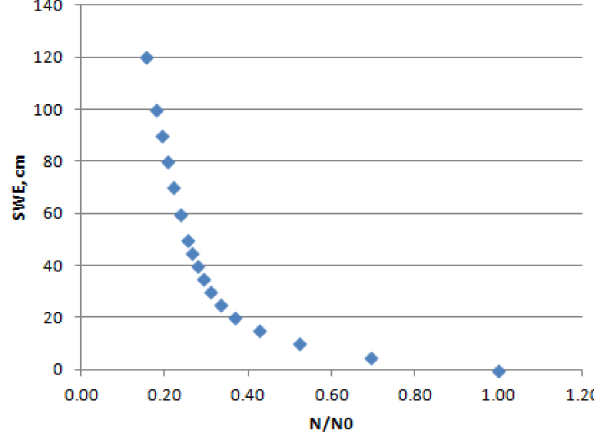
Figure A1. Grounded in situ CRNS measurement approximation relative to SWE and N/N 0